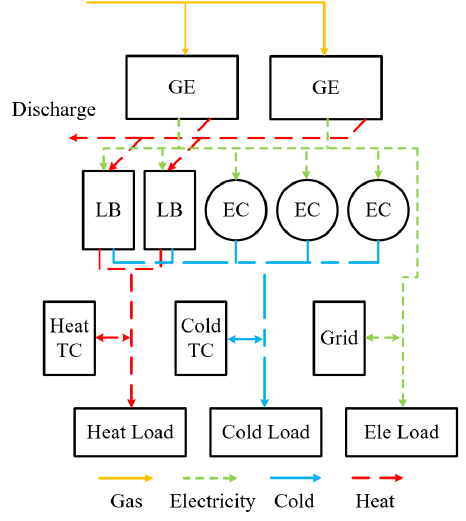
Figure 2. Energy flow diagram of